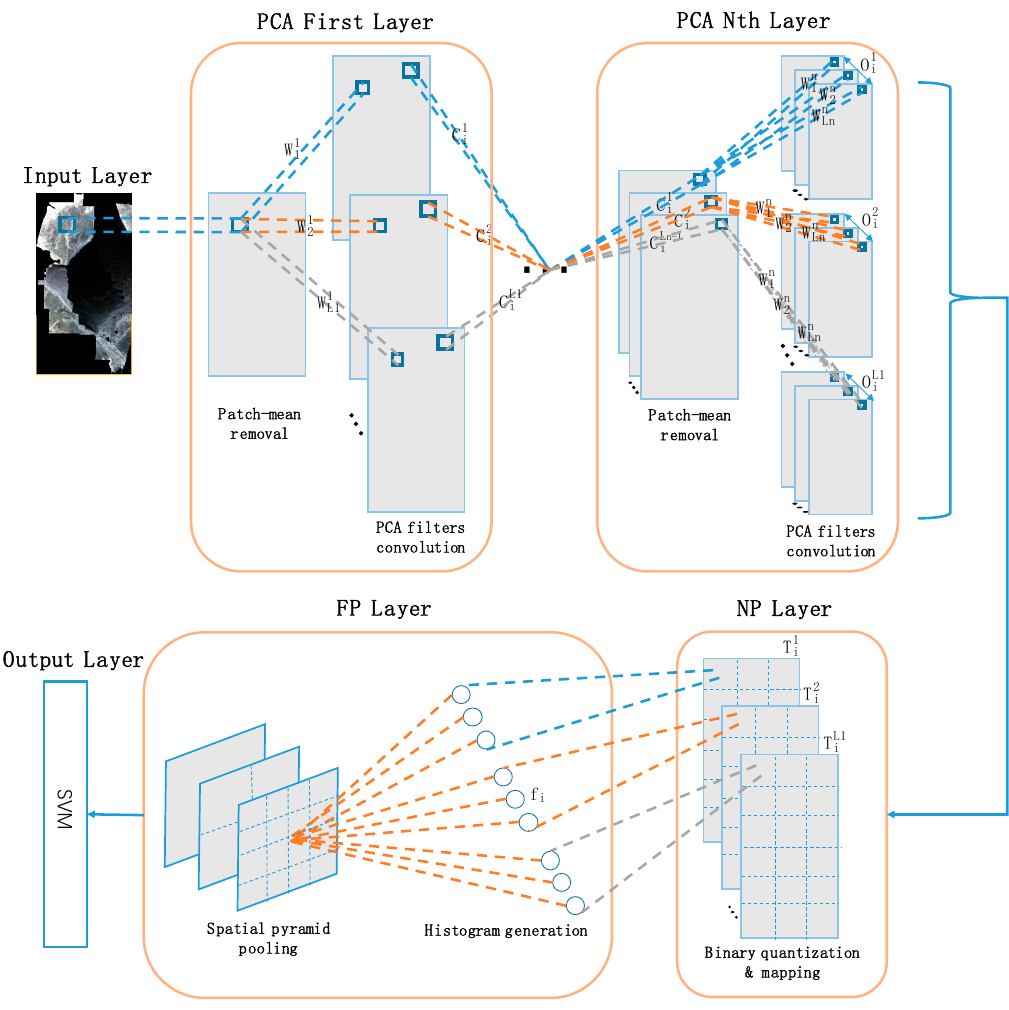
Figure 2. Structural diagram of the PCANet